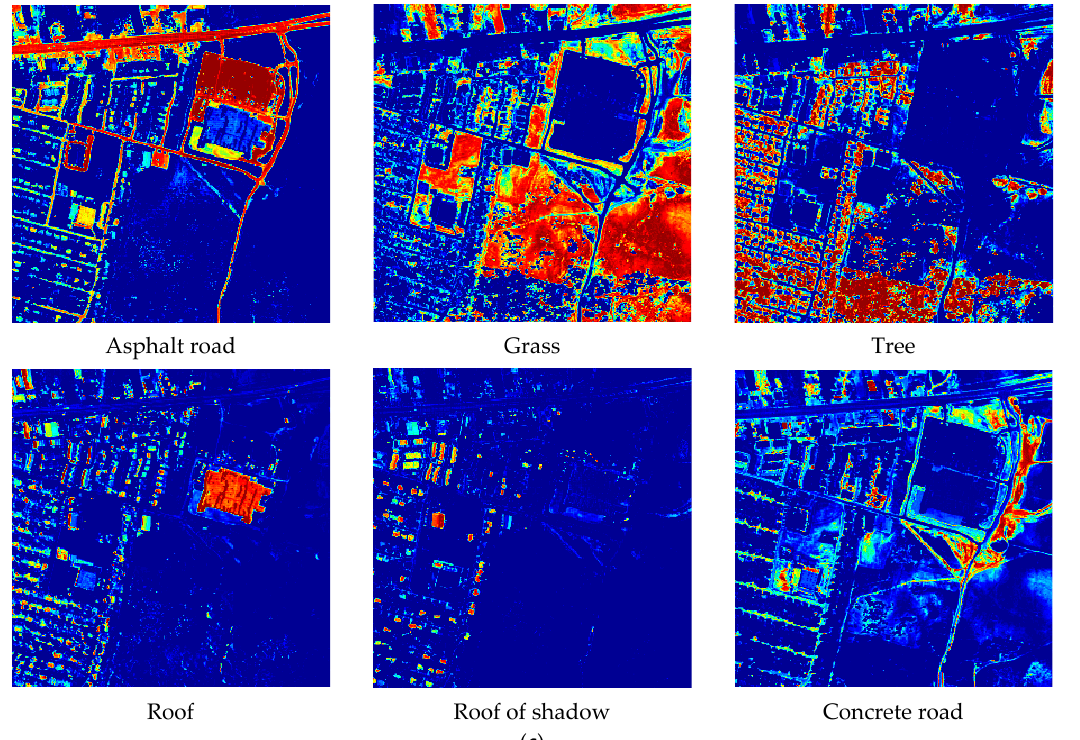
Figure 10. Hyperspectral Digital Imagery Collection Experiment (HYDICE) Urban . ( a ) R-2. ( b ) Reference endmember signatures. ( c ) Reference abundances.